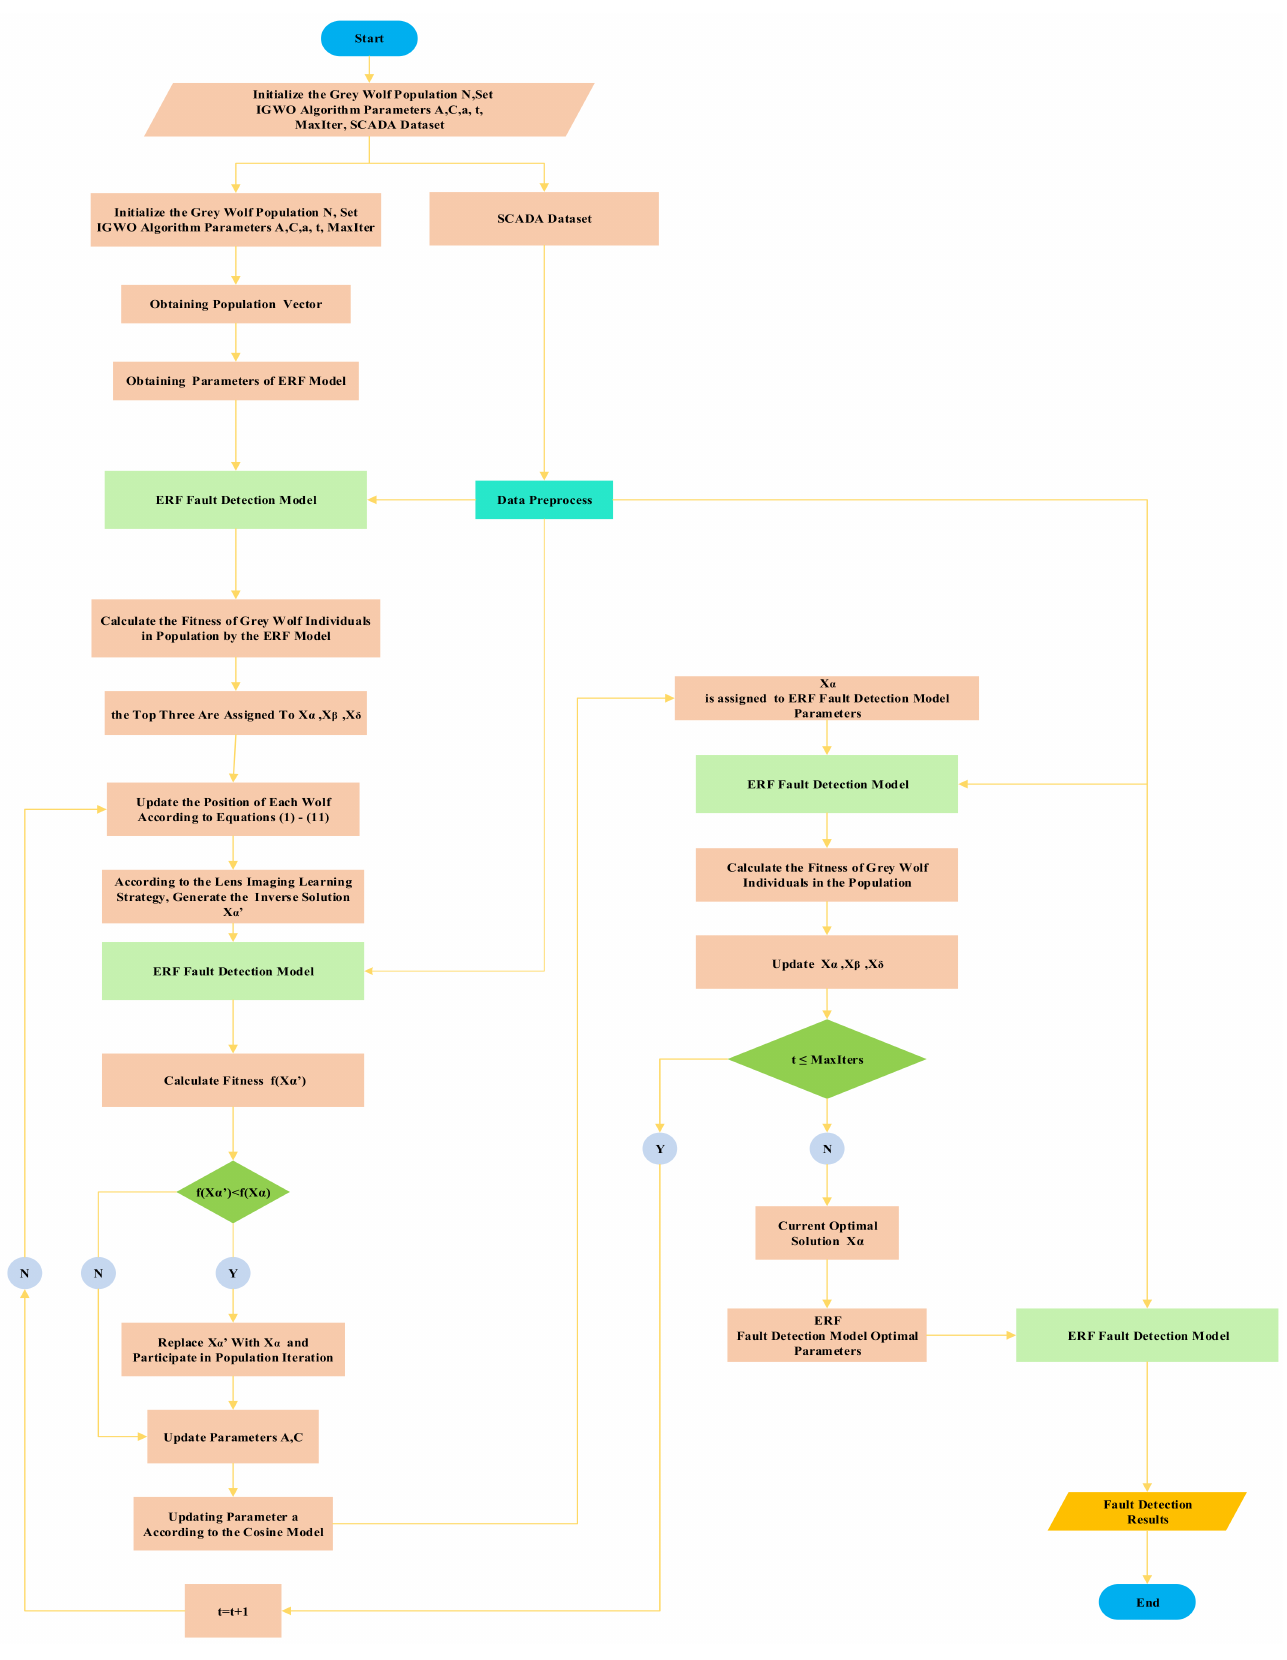
Figure 4. FD flow chart of wind turbine electric pitch system based on